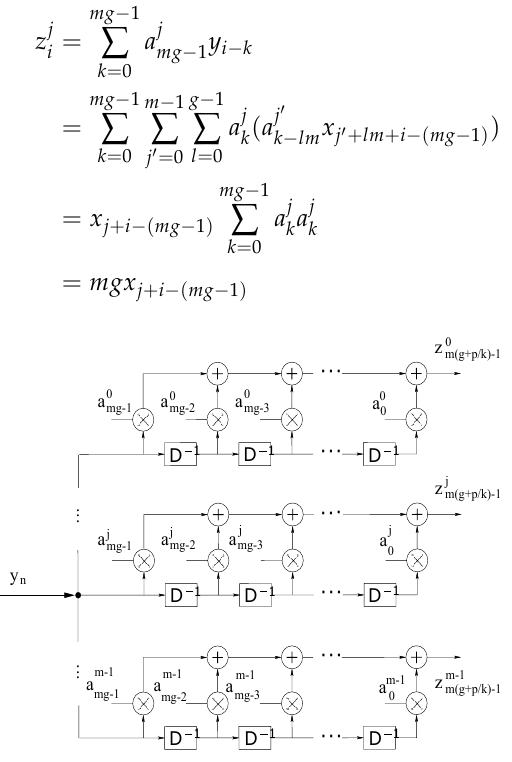
Figure 2. General structure of the wavelet